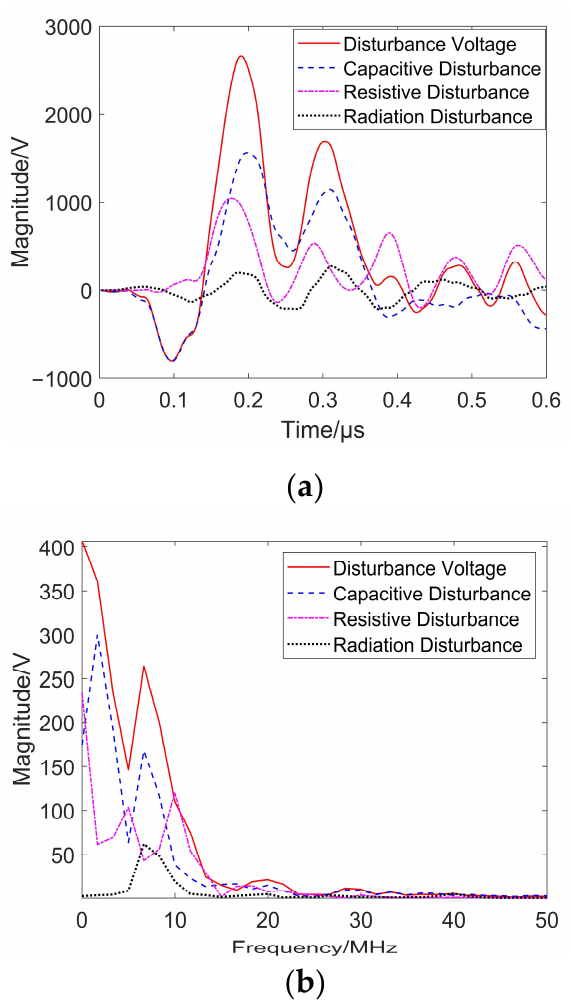
Figure 10. Schematic diagram of conduction disturbance simulation calculation.